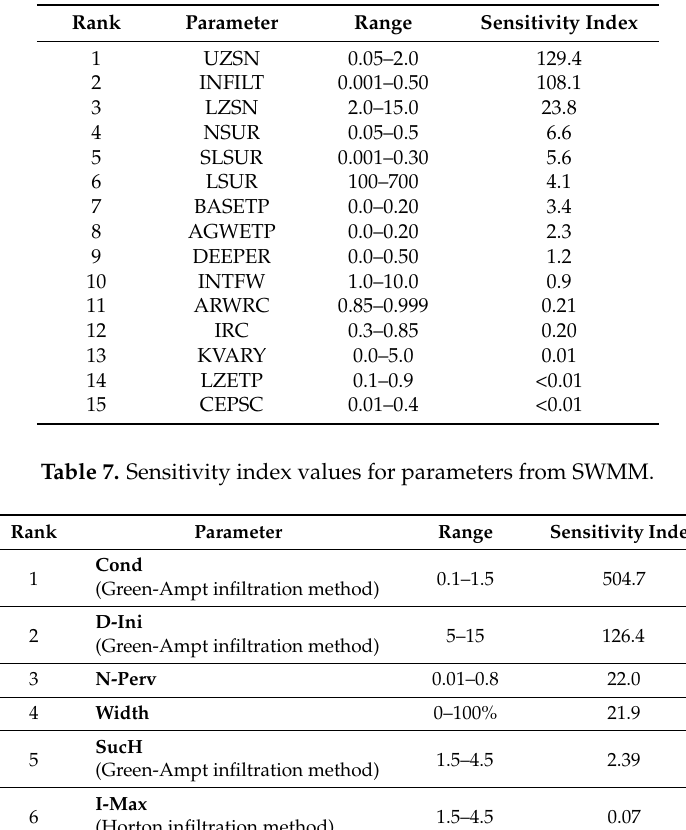
Table 6. Sensitivity index values for parameters from the HSPF model.